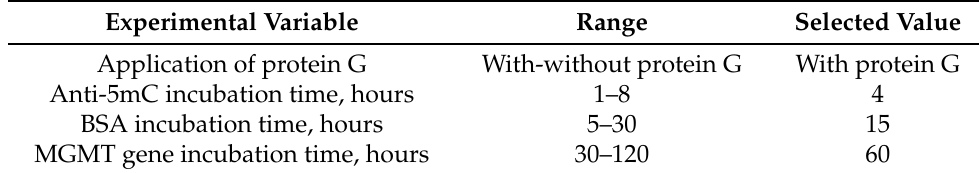
Table A1. Optimised preparation steps and selected values.